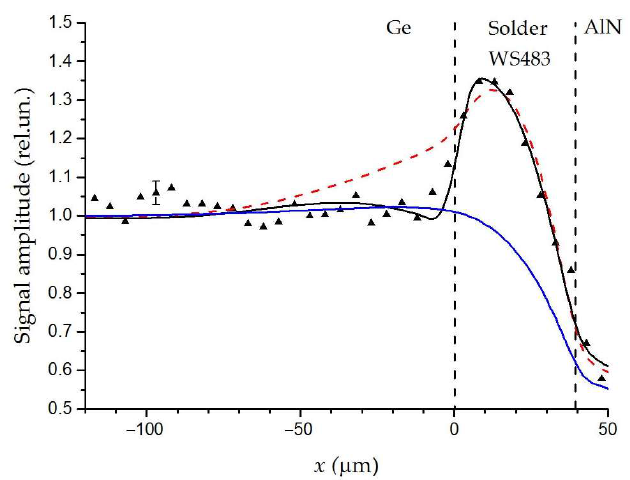
Figure 3. The PBD-signal amplitude. Black triangles are the experimental data. The blue curve corresponds to the solder thermal conductivity K = 22 W/(m K) and the perfect Ge − solder interface. The red curve corresponds to K = 33 W/(m K) and the Ge − solder interface with r th = 3 × 10 − 6 m 2 K/W and z th = 0. The black curve corresponds to K = 28 W/(m K), r th = 3 × 10 − 7 m 2 K/W, and z th = i 6.8 × 10 5 Wm − 2 K − 1 . Dash lines are solder layer boundaries. Adopted with permission from [58]. Copyright (2018), Elsevier.